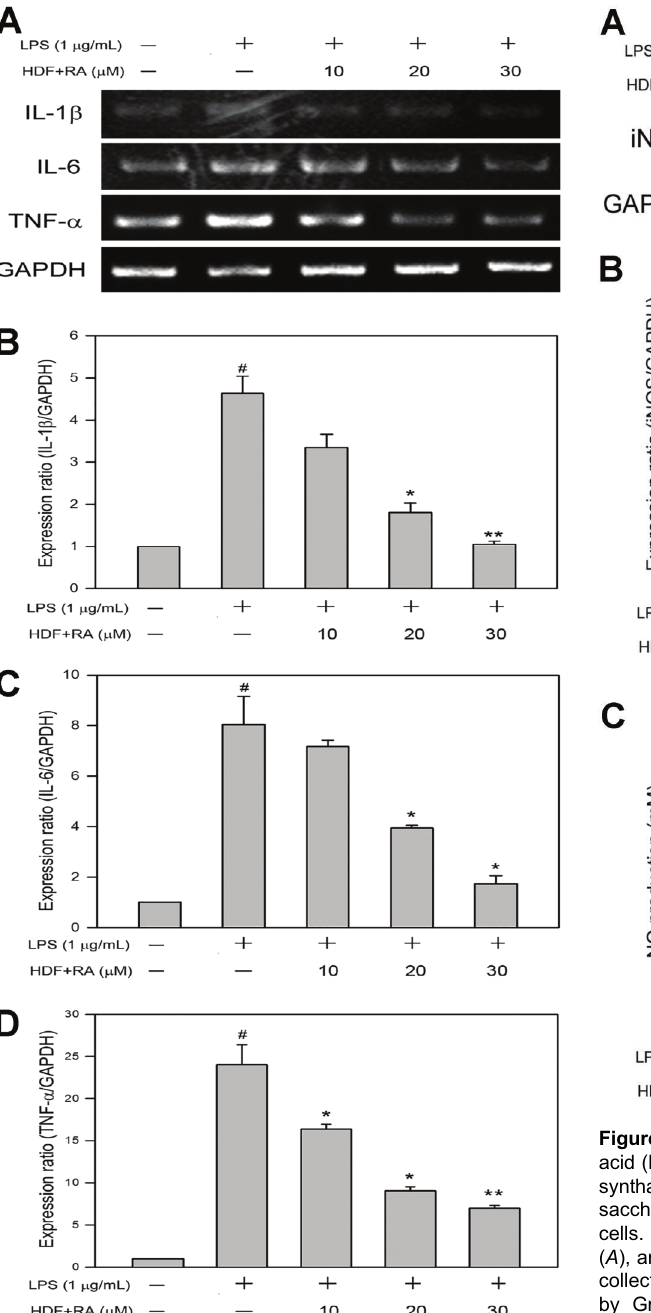
Figure 2. Hemodialysis fl uid (HDF) supplemented with rosmarinic acid (RA) inhibited mRNA expression of pro-in fl ammatory cytokines in LPS-stimulated human umbilical vein endothelial cells. Detection and quantitation of IL-1 b , IL-6 and TNF- a were done by A , RT-PCR, and B – D , q-PCR. Data are reported as means ± SD. Three independent experiments were performed for quantitative and statistical analysis. # P o 0.05 compared to control; *P o 0.05 and **P o 0.005 compared to LPS alone (ANOVA).